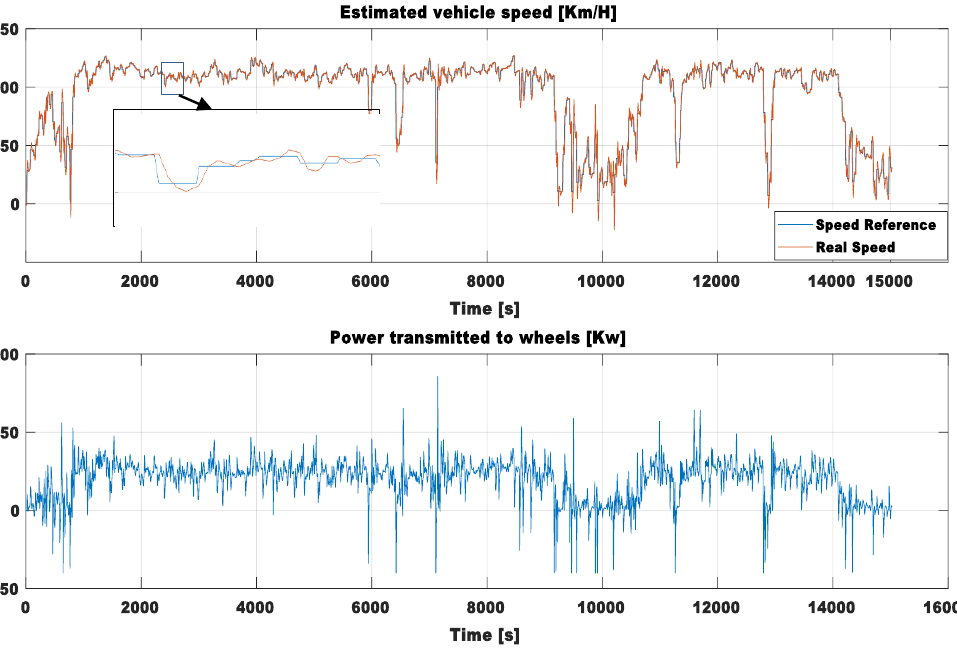
Figure 8. The speed and the power transmitted to the wheels on the Safi/Rabat